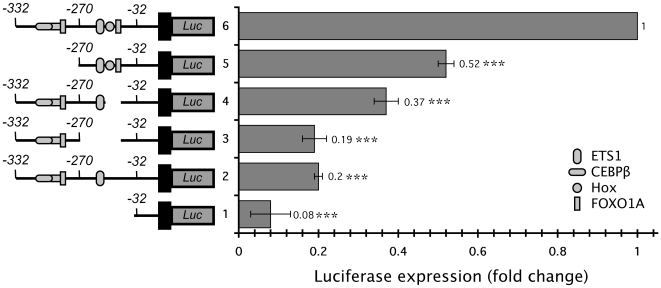
Identification of the HoxA-11/FOXO1A responsive region of the dPRL promoter.The expression of luciferase was assayed in HeLa cells transiently transfected with HoxA-11 and FOXO1A and (from top to bottom) either dPRL-332/luc3, dPRL-270/luc3, dPRL(−332/−232)/−32/luc3, dPRL(−332/−270)/−32/luc3, dPRL-32/luc3 or dPRL-332/luc3mutHox. Results are shown as fold changes relative to luciferase expression in cells cotransfected with HoxA-11/FOXO1A and dPRL-332/luc3. A schematic of the location of transcription factor binding sites and deletions is shown. n = 6 replicate experiments, means±SEM. ***, P<0.001 (t-test compared to dPRL-332/luc3).